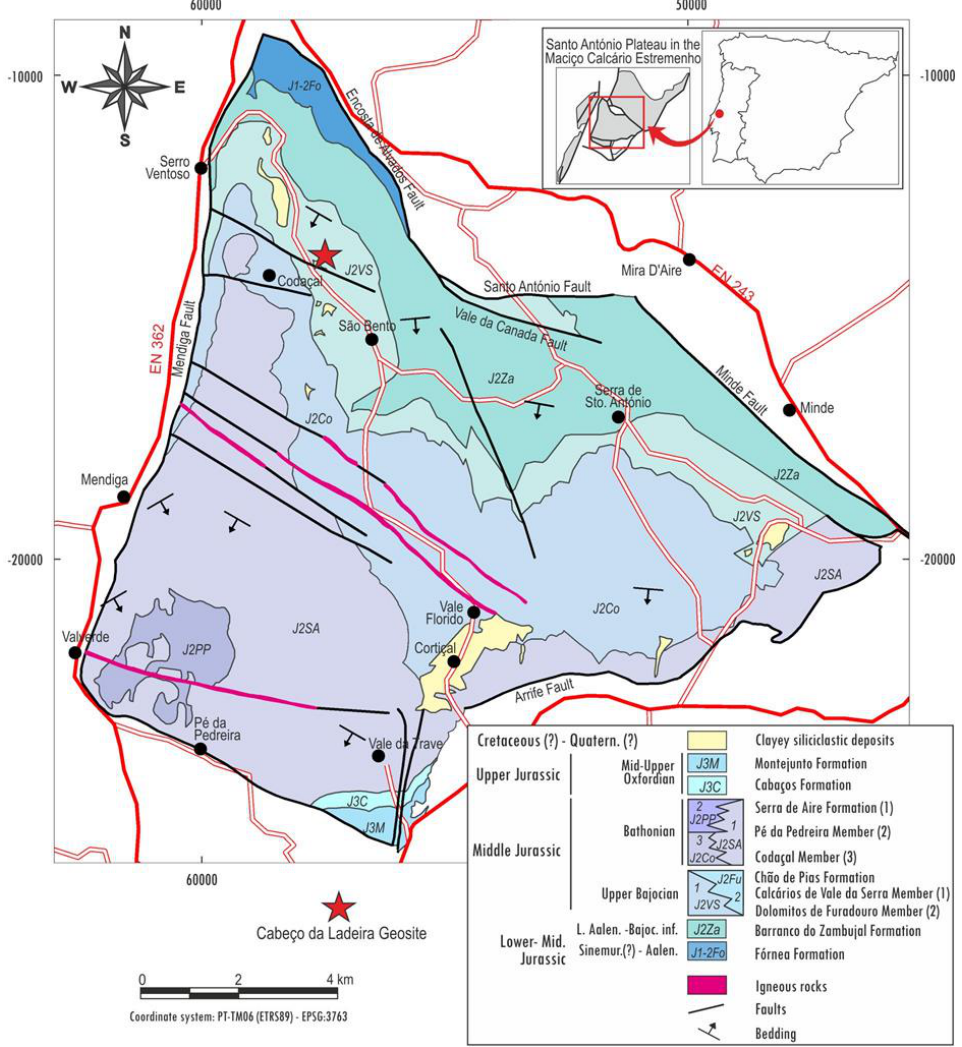
Figure 1. Geological setting of the Cabeço da Ladeira paleontological site (adapted from the Geologi- cal Map of Portugal, sheets 26-B, 26-D, 27-A, and 27-C, scale 1:50,000, edited by LNEG). Lithostratig- raphy from